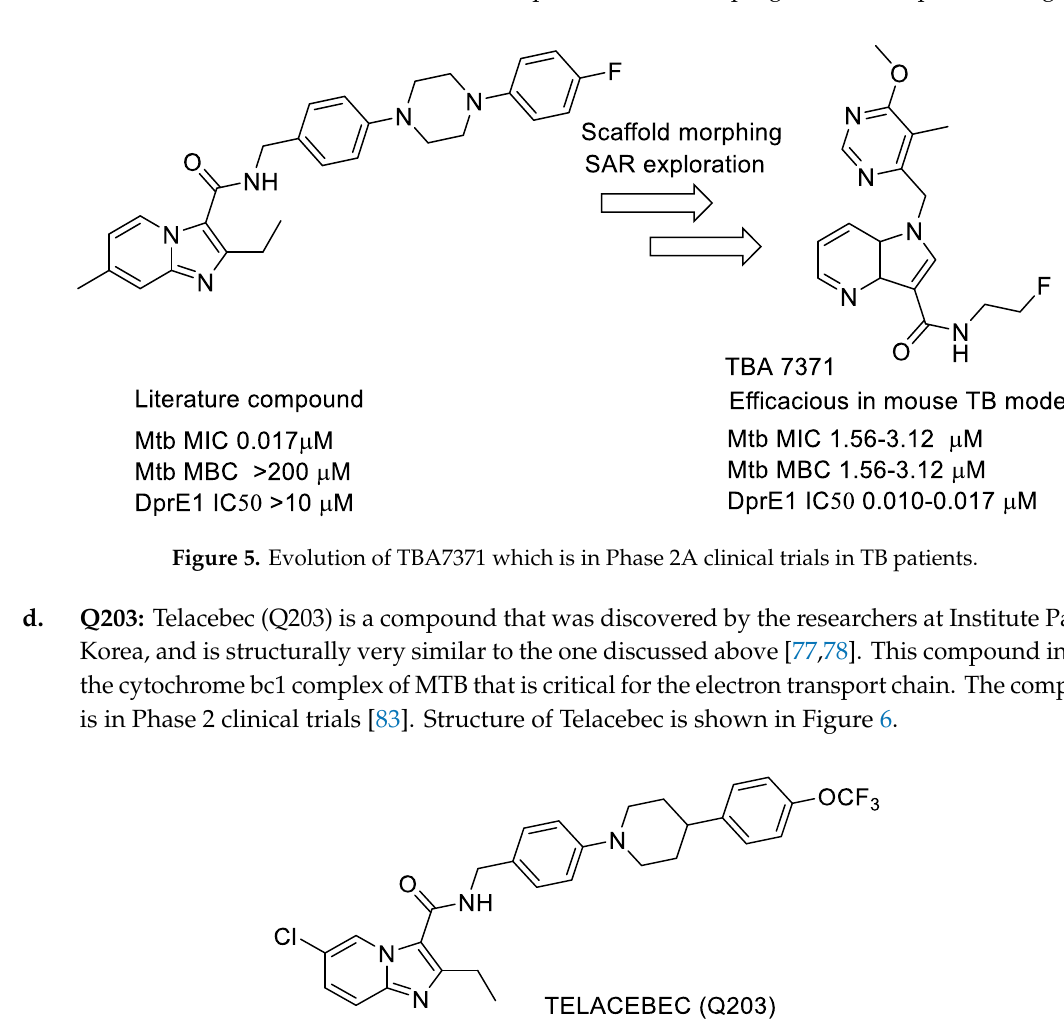
Figure 7. Structure of OPC-167832. Phenotypic-Screening Efforts at AstraZeneca India The continued success of phenotypic screening as a viable alternative to discover novel inhibitors of MTB was based on its ability to circumvent the failure to convert enzyme inhibition into antibacterial activity. The advent of ‘rapid sequencing technology’ provided an impetus to this approach because of the ability to rapidly sequence the genome to elucidate mechanism of action. This led AZ India to focus on phenotypic screening for lead generation. A diversity library of 100,000 compounds was assembled and used for screening directly against both M. smegmatis or Mycobacterium bovis BCG cells as surrogates for MTB. Several novel scaffolds and their cognate targets were identified, confirming the validity of this approach; a short list of the results obtained is shown in Table 3. Many of the novel scaffolds identified were found to target DprE1 or the ATP synthase in target enzyme assays. Table 3. Phenotypic screening-based efforts at AstraZeneca India (AZI). Screening Mode